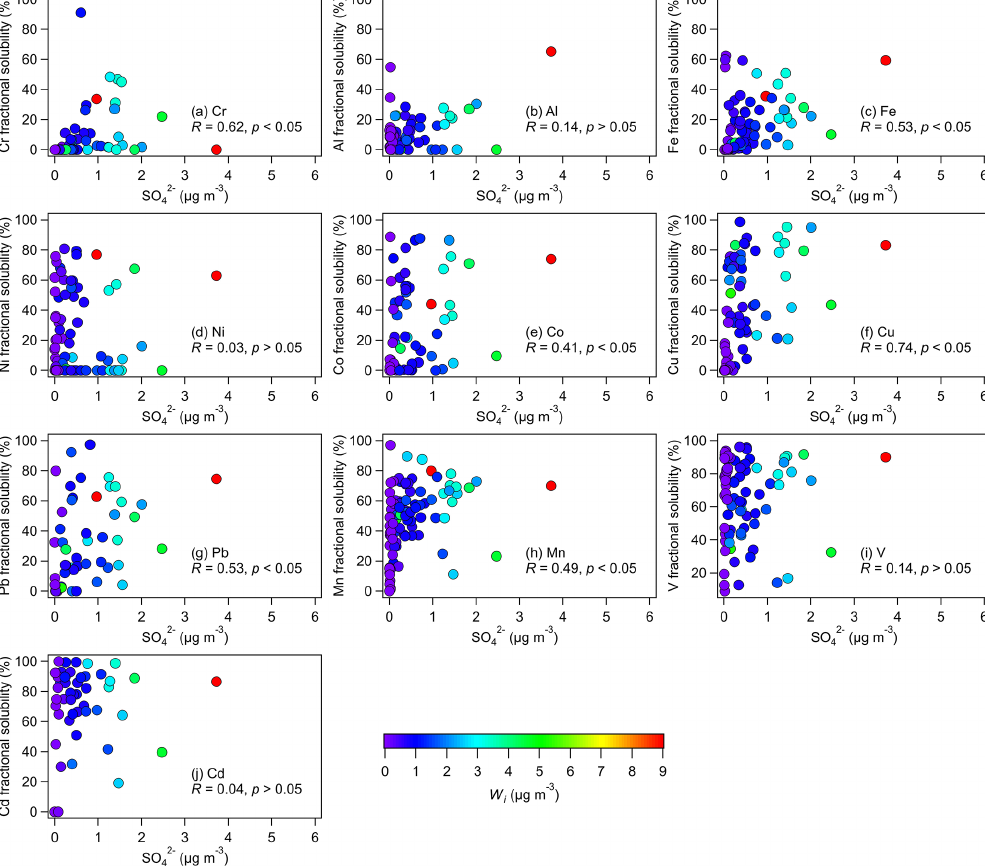
Figure 6. Relationships between the metal fractional solubilities and sulfate mass concentration in fine aerosols. Only data with nonzero total metal concentrations were used in the figures. Also shown are the Spearman correlation coefficients for each relationship. The symbols are colored by the corresponding W i concentrations calculated by ISORROPIA II. The W i concentrations increased with sulfate